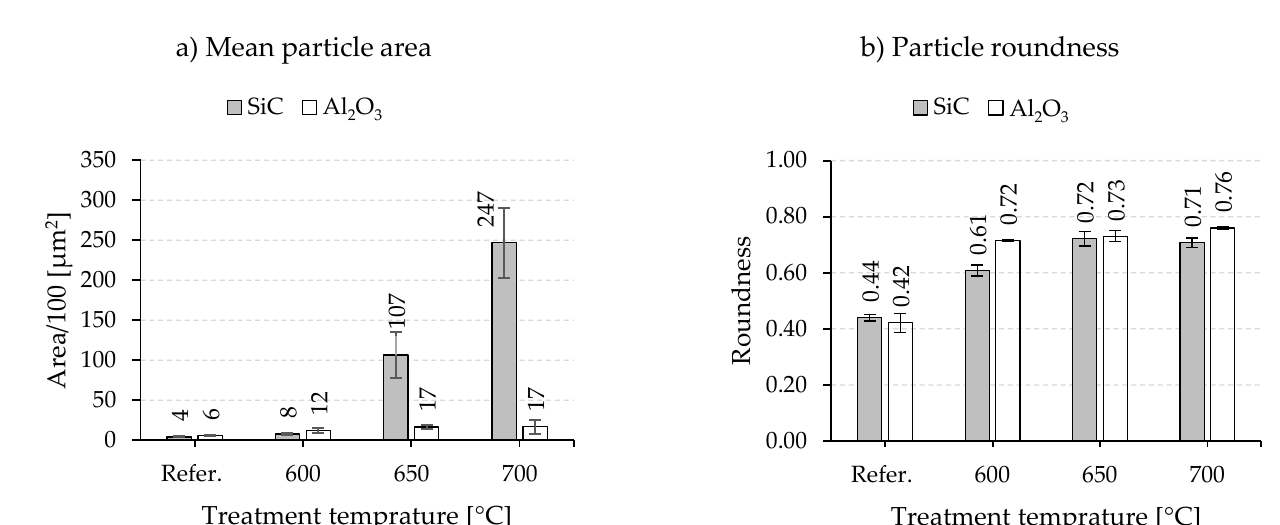
Figure 12. Mean particle area ( a ) and roundness ( b ) after a thermal post-treatment in a tube furnace at different temperatures for 1 min above the melting point of the AlSi10Mg alloy for 5 vol% SiC and Al 2 O 3 reinforcement (composite powders produced with menthol as PCA).